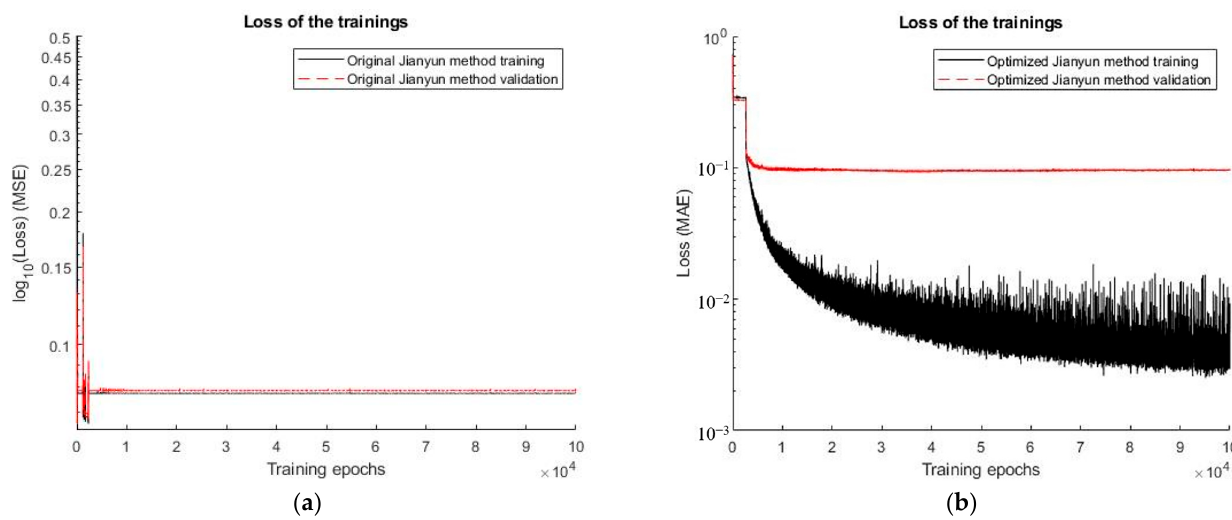
Figure 14. ( a ) Verification training epoch obtained with Yangzhou’s method before optimization. ( b ) Verification training epoch obtained with Yangzhou’s method after optimization.